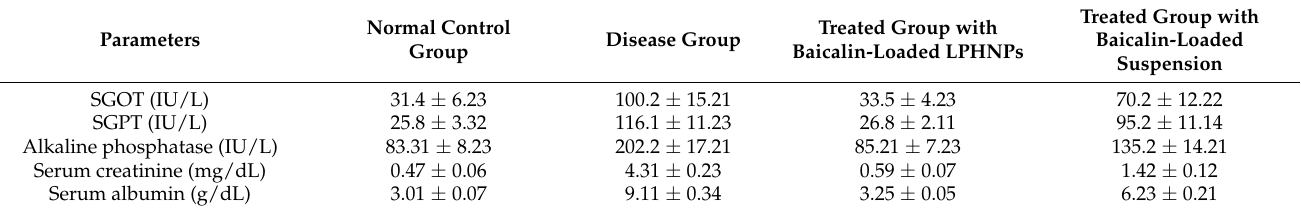
Table 4. Biochemical parameters evaluated in rats treated with baicalin colon-targeted LPHNPs over baicalin suspension.